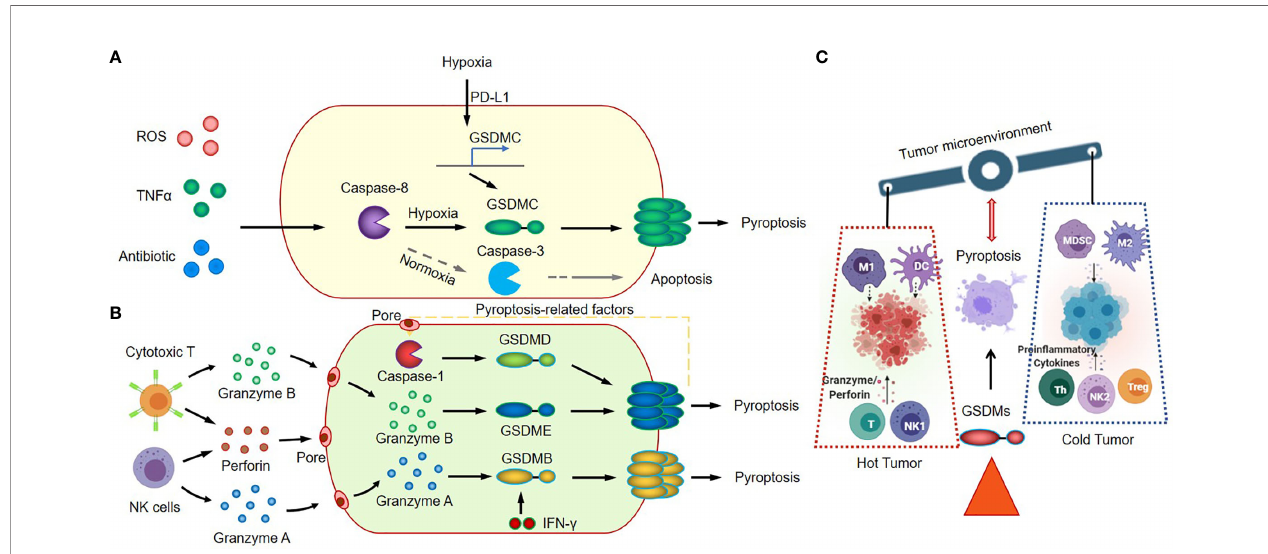
FIGURE 2 | Canonical in fl ammasome signaling in cancer immunology. (A) GSDMC-dependent in fl ammasome signaling and pyroptosis pathway. (B) Granzyme A/B- mediated cytotoxic lymphocyte killing mechanism and GSDMB/GSDMD/GSDME induce tumor cell pyroptosis. (C) GSDMs-mediated in fl ammasome activation and pyroptosis regulate antitumor